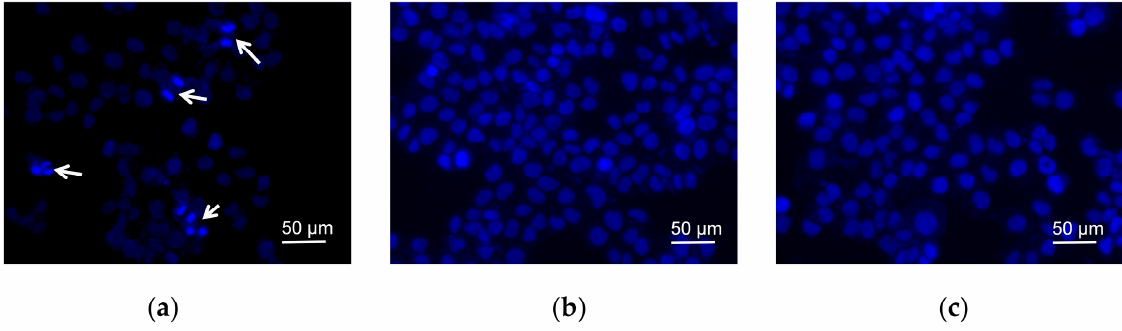
Figure 3. Fluorescent dye Hoechst-33342 was used for nuclear staining and changes were observed after adding different compounds; ( a ) negative control nucleus morphology and cell number; ( b ) nucleus morphology and cell number after adding SW91; ( c ) nucleus morphology and cell number after adding dutomycin. Table 1. Apoptosis degree of SW91 and dutomycin in cancer cell Smmc-7721. Concentration